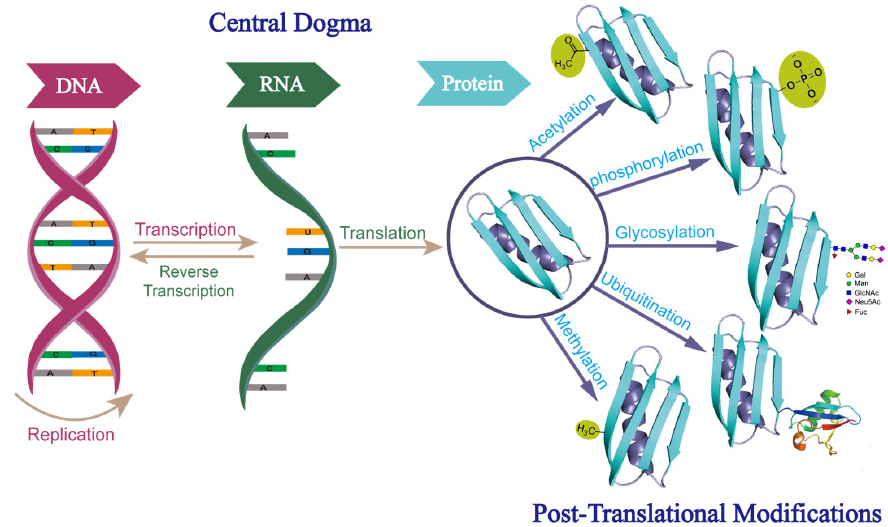
Figure 1. Central dogma of molecular biology and different forms of post-translational modifications. Abbreviations: Gal, galactose; Man, mannose; GlcNAc, N-acetylglucosamine; Neu5Ac, sialic acid; Fuc, fucose.